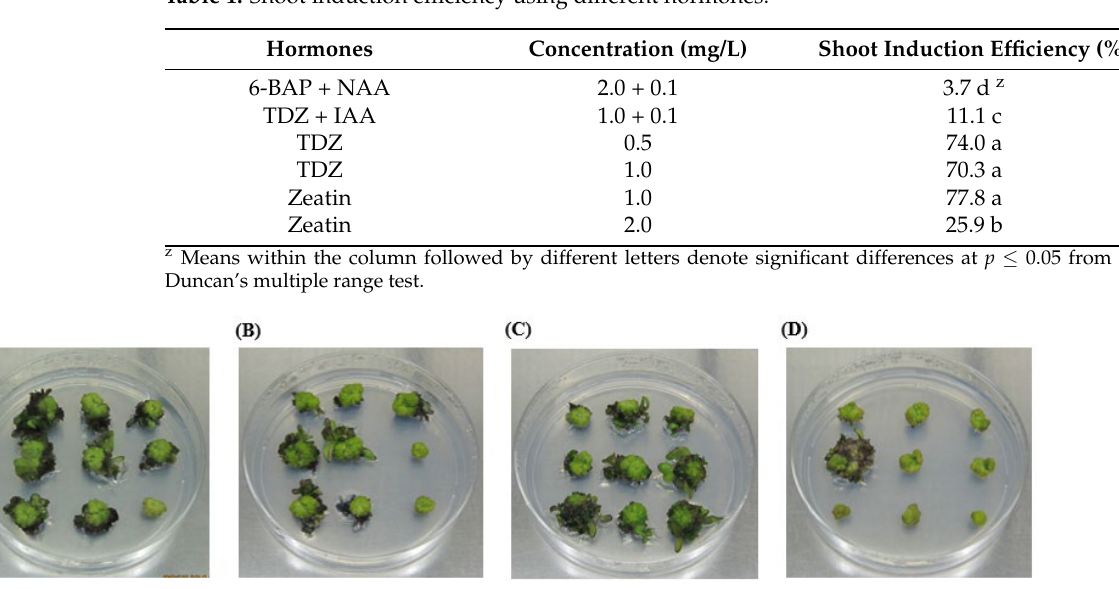
Figure 3. Shoot induction by cytokinin treatments in Petunia protoplast-derived regeneration, exhibiting relatively higher shooting rates of 74%, 70%, 78%, and 26% at thidiazuron (TDZ) 0.5 mg/L ( A ), TDZ 1.0 mg/L ( B ), zeatin 1.0 mg/L ( C ), and zeatin 2.0 mg/L ( D ), respectively.